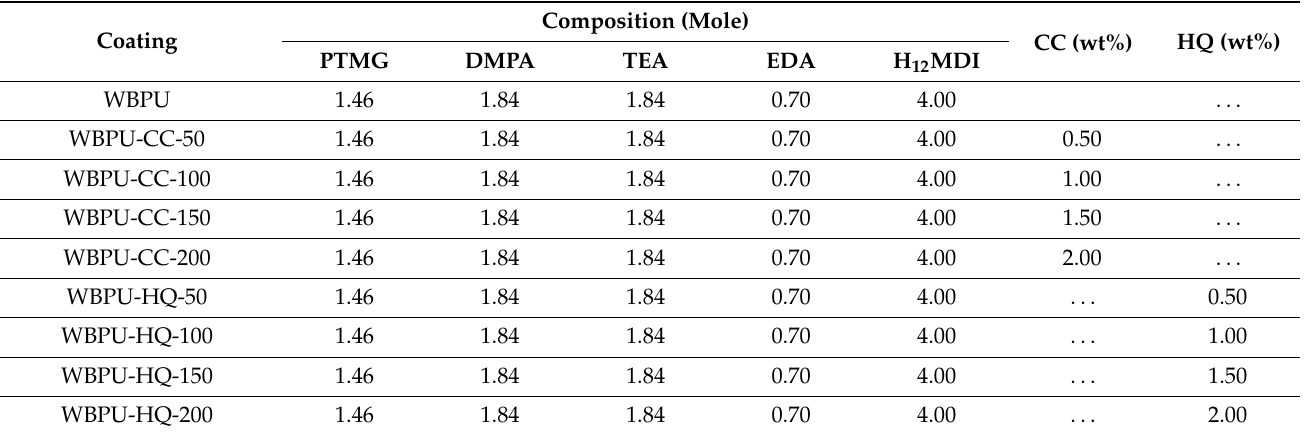
Table 1. Sample designation and composition of